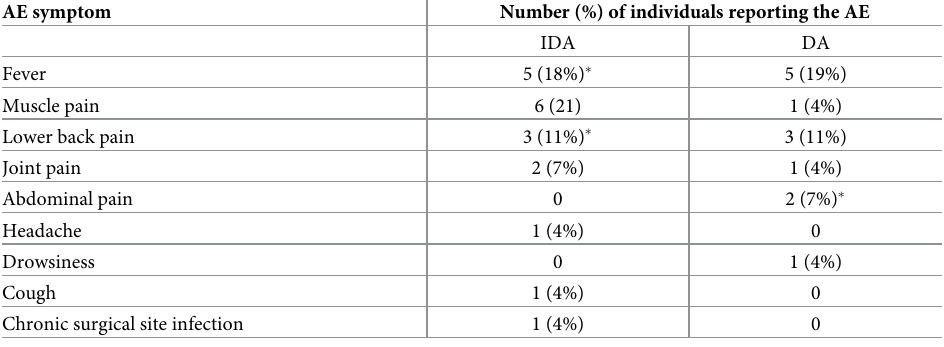
Table 3. Adverse events (AE) by treatment group reported through seven days of follow-up. AE symptom Number (%) of individuals reporting the AE IDA DA Fever 5 (18%) � 5 (19%) Muscle pain 6 (21) 1 (4%) Lower back pain 3 (11%) � 3 (11%) Joint pain 2 (7%) 1 (4%) Abdominal pain 0 2 (7%) � Headache 1 (4%) 0 Drowsiness 0 1 (4%) Cough 1 (4%) 0 Chronic surgical site infection 1 (4%) 0 The table lists all AEs reported or observed. Some participants experienced more than one AE. � 4 subjects experienced AEs on more than one